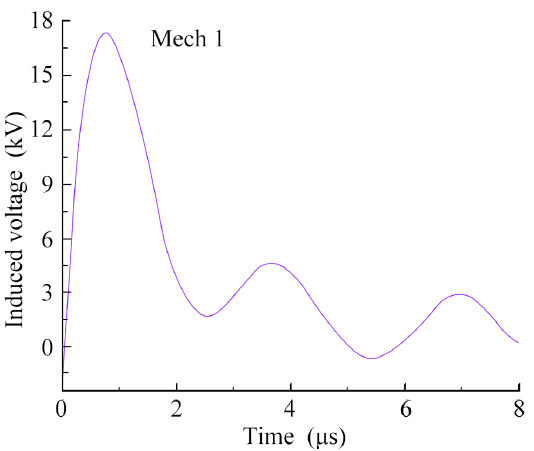
Figure 14. Induced voltage in mesh 1 under +10/350 µ s and 50